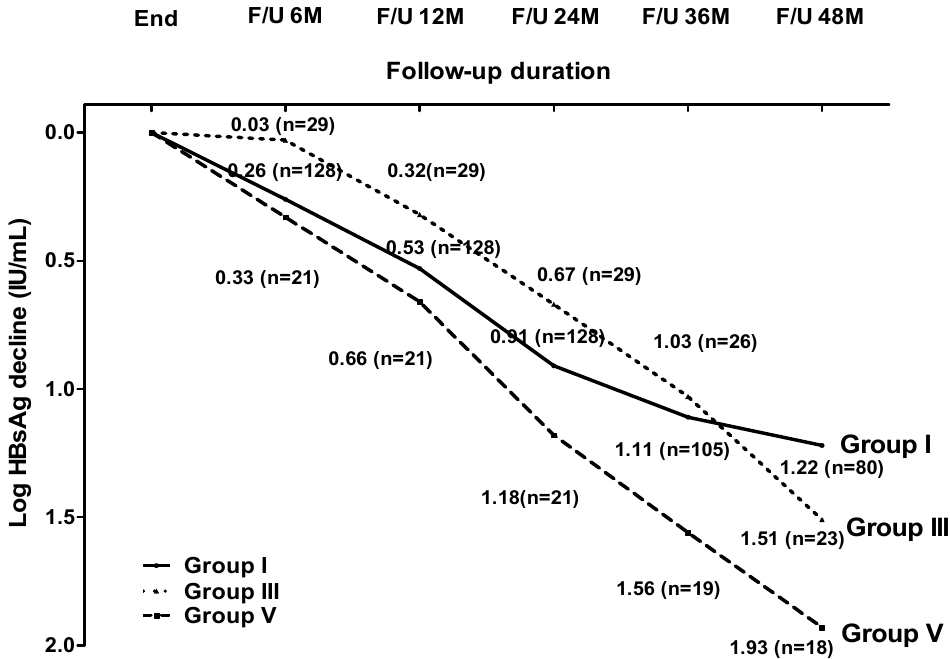
Figure 3. HBsAg decline stratified by the different relapse pattern. Group I: 128 patients with a sus ‐ tained virological suppression; Group III: 29 patients with persistent virological suppression after virological relapse; Group V: 21 patients with persistent virological suppression after clinical relapse.